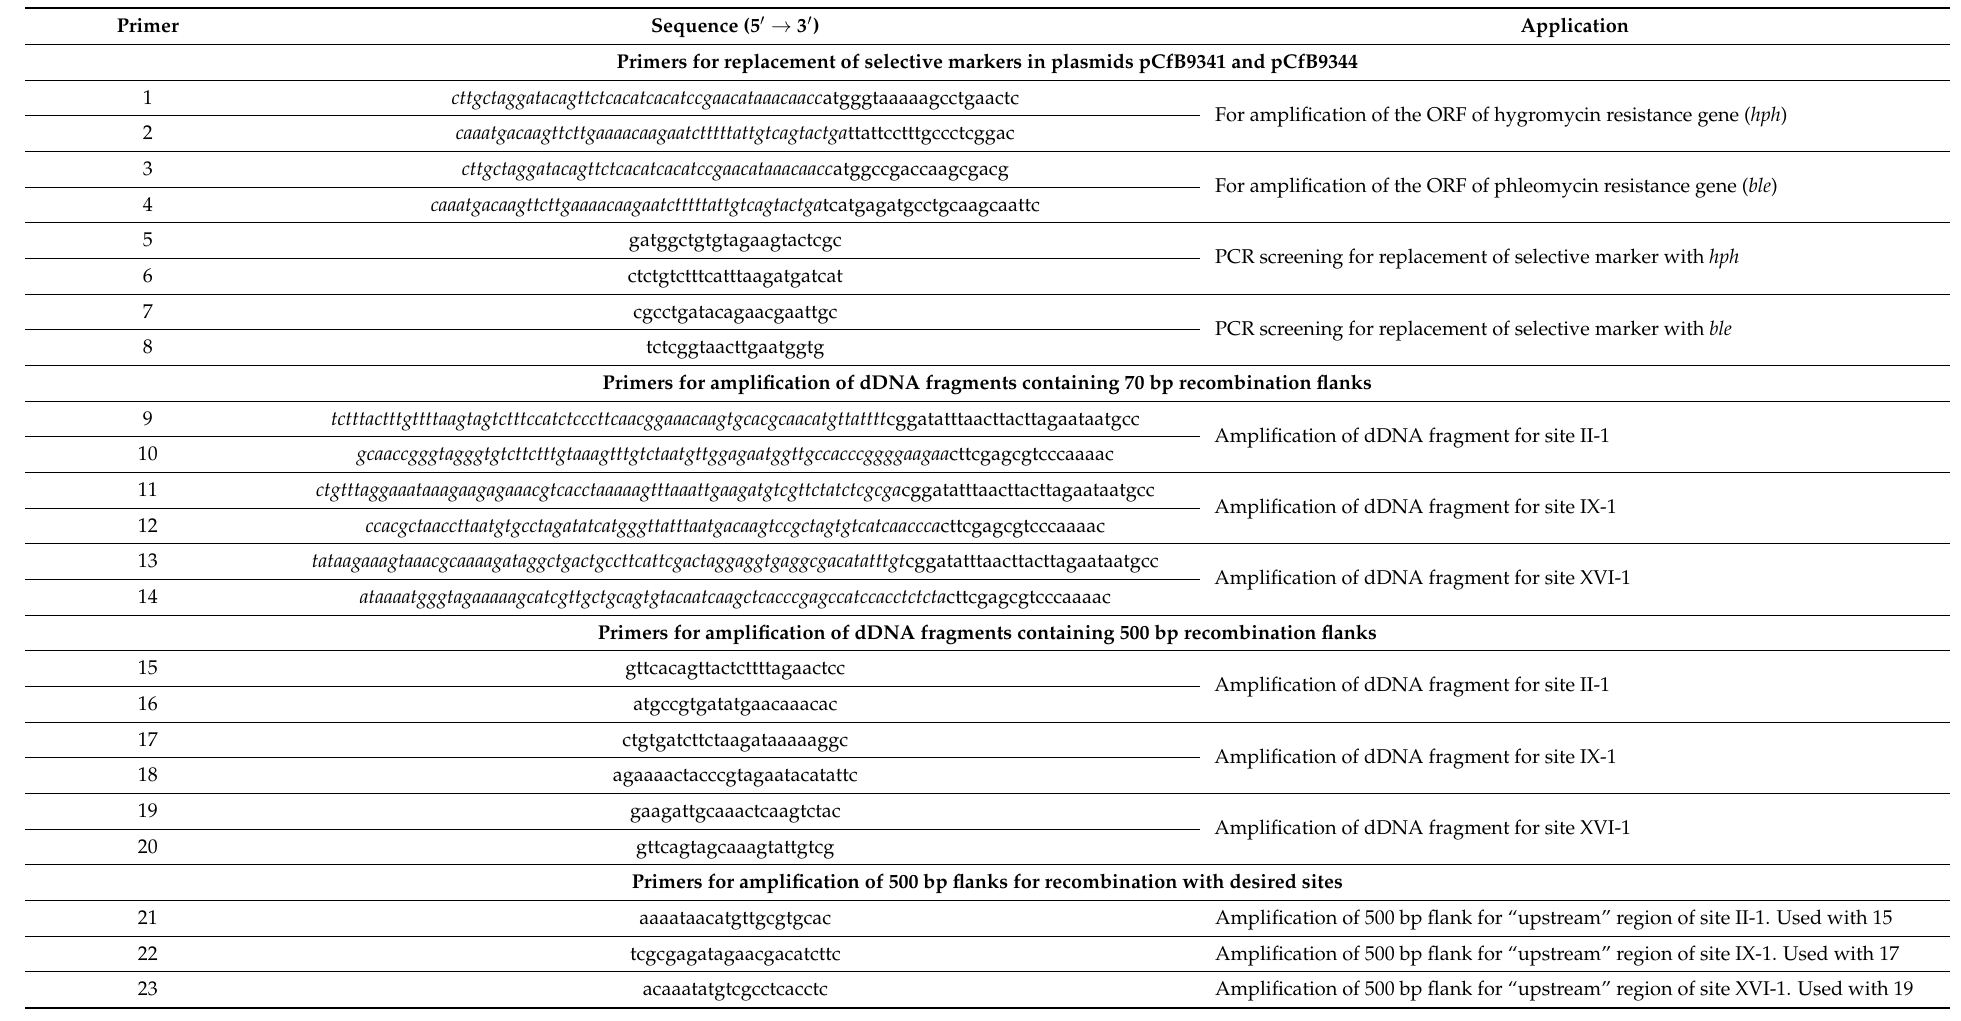
Table 2. List of primers used in this